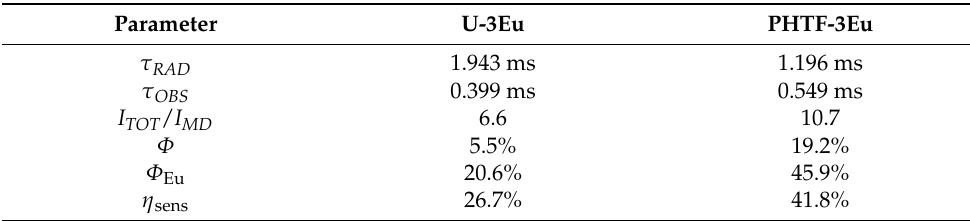
Table 1. Main photophysical parameters of U-3Eu and